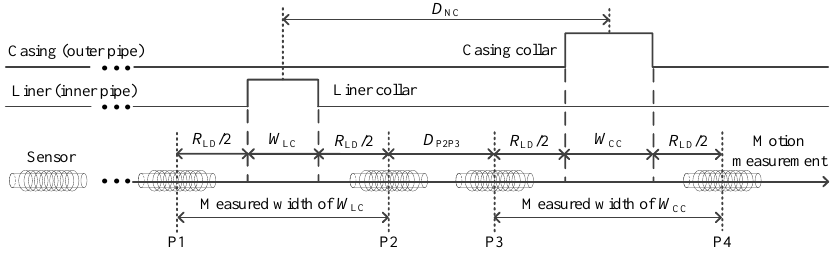
Figure 16. Relationships among the longitudinal detection range R LD , the distance between nearby liner and casing collars D NC , and the measured width.